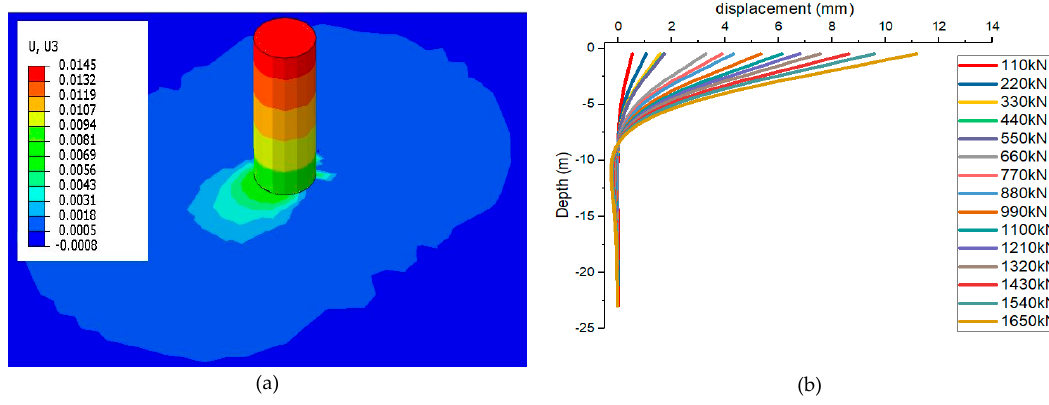
Figure 11. The displacement of the lateral load on the pile head; ( a ) Lateral deformation of piles; ( b ) Lateral deformation profiles.